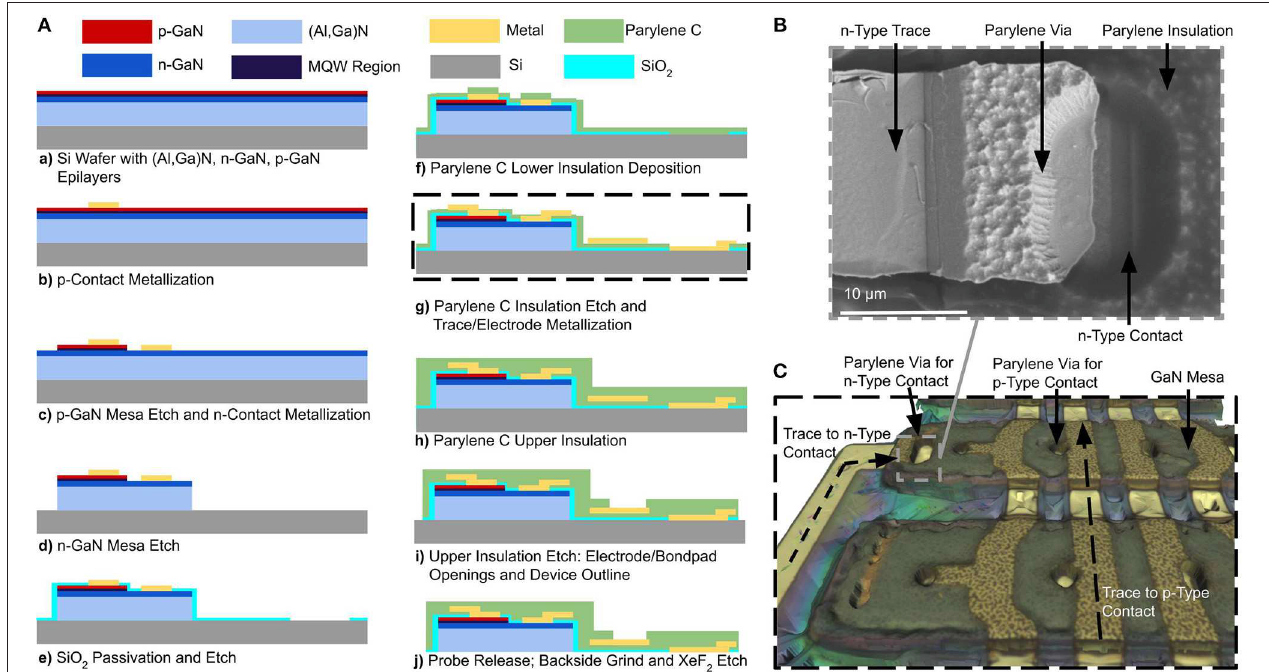
FIGURE 3 | (A) Schematic process flow for a µ LED neural probe, (B) Top-down SEM photomicrograph image of a Parylene C via formed with a sidewall from a photoresist underexposure process. This image is taken perpendicular to the surface; the sloped edge is evident due to the width of the edge. Metal deposited via evaporation is continuous from the top surface of the Parylene C to the µ LED contact. (C) 3D optical microscope image of GaN mesa structure during fabrication step (g). Traces for p -type contacts run orthogonally to the mesas and connect to the p -type GaN contacts through Parylene C vias. Traces for the n -type contacts are routed through a via on the edge of the GaN mesa and are connected to n -type contacts which are patterned along the mesa in the n -type GaN layer.